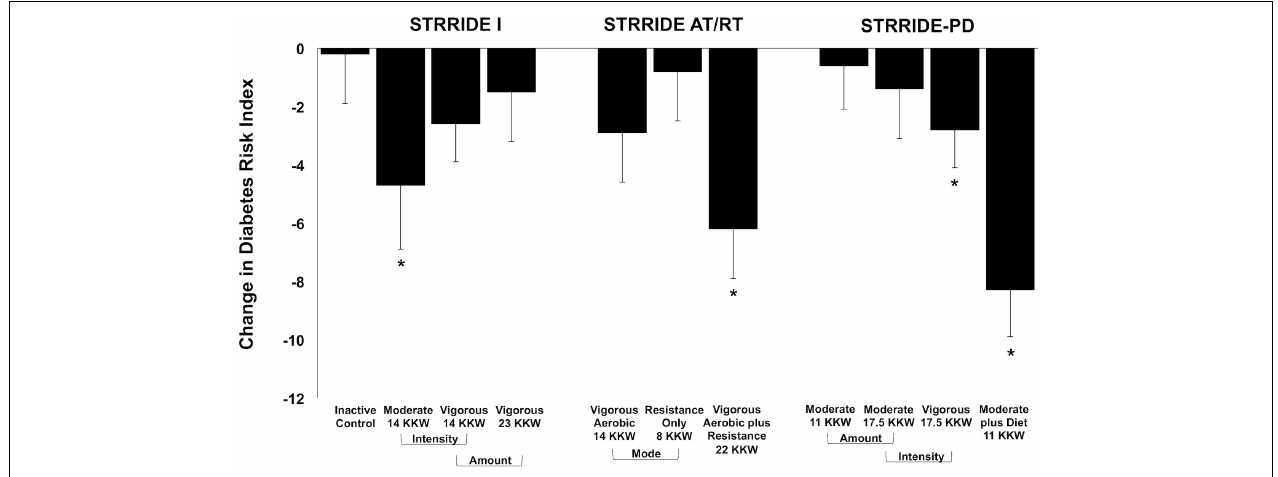
FIGURE 2 | Change in Diabetes Risk Index following intervention across all groups from STRRIDE I, STRRIDE AT/RT, and STRRIDE-PD. Moderate and vigorous refer to prescribed aerobic exercise intensity. Prescribed amount of exercise represented by kcal/kg of body weight/week (KKW). *Denotes significant within-group change following